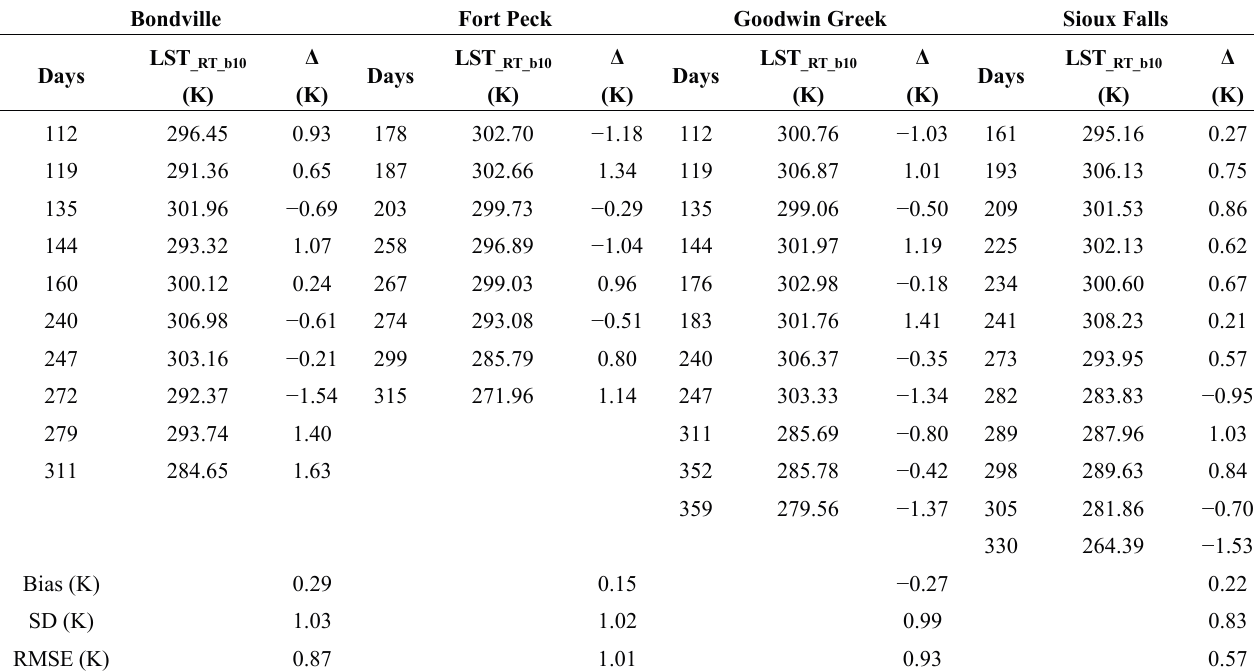
) using radiative transfer equation-based method from _RT_b10 and LST for four selected _RT_b10 _g